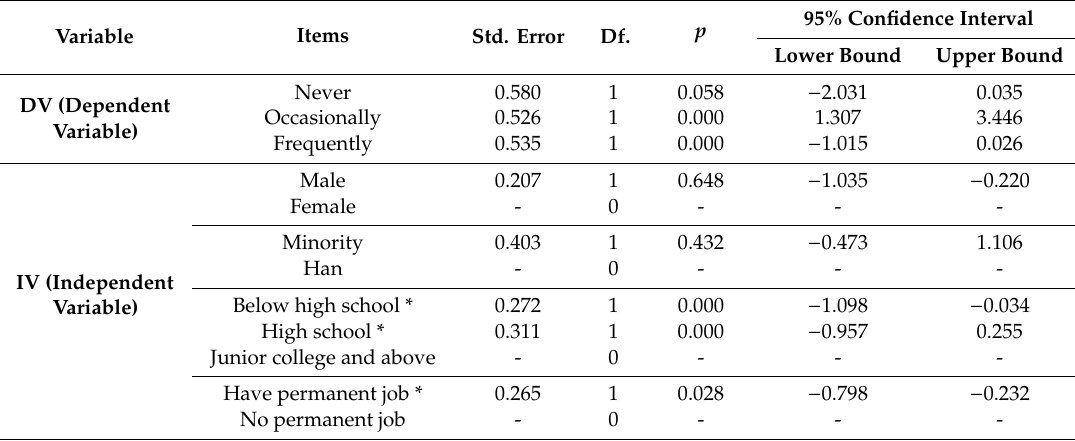
Table 7. Estimated parameters in ordered logistic